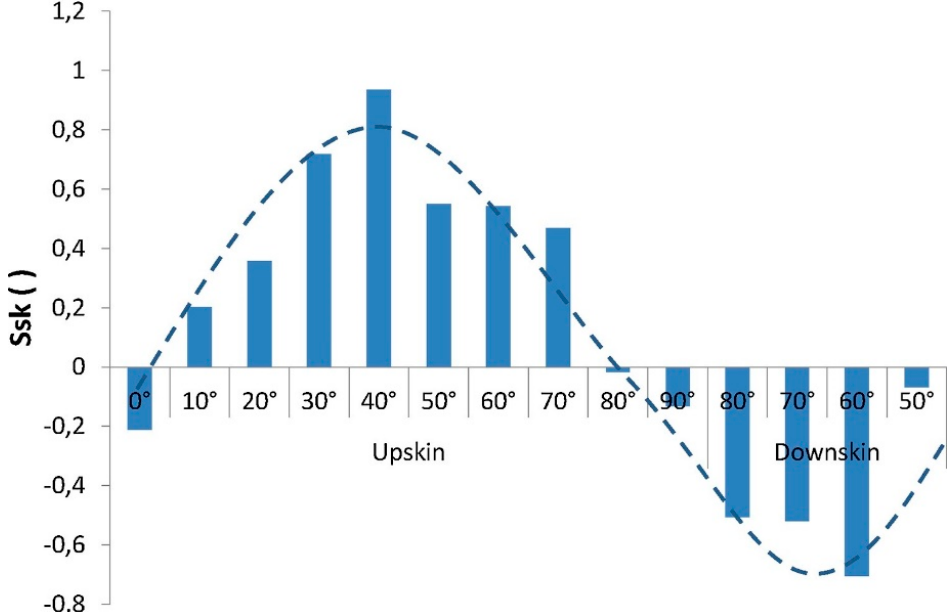
Figure 1. The relationship of downskin and upskin angles to skewness for SLM Ti-6Al-4V with the permission of Copy Clearance Center [55].